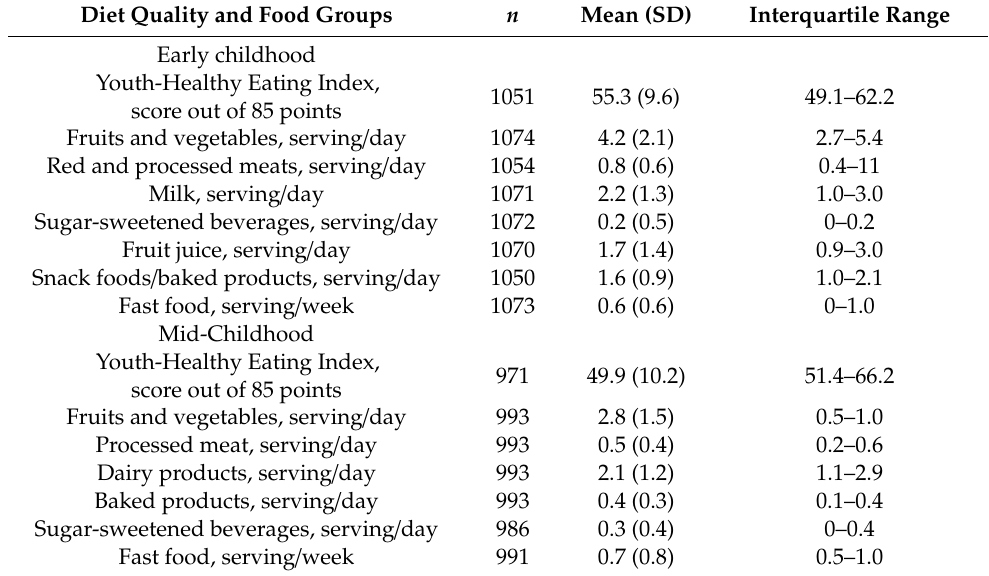
Table 2. Dietary intakes in early and mid-childhood among participants from Project Viva included in this analysis.